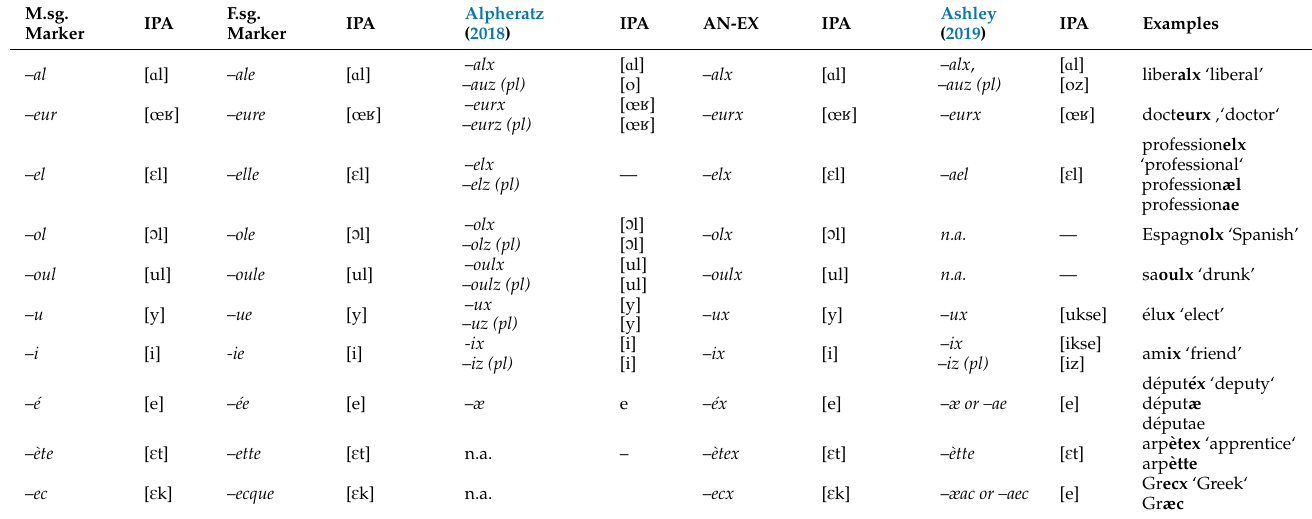
Table 2. Masculine and Feminine Homophones.